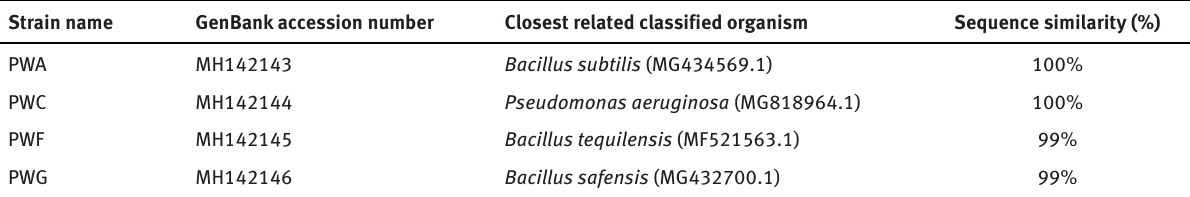
Table 1: PHA producing bacteria isolated from Potwar oil field produced